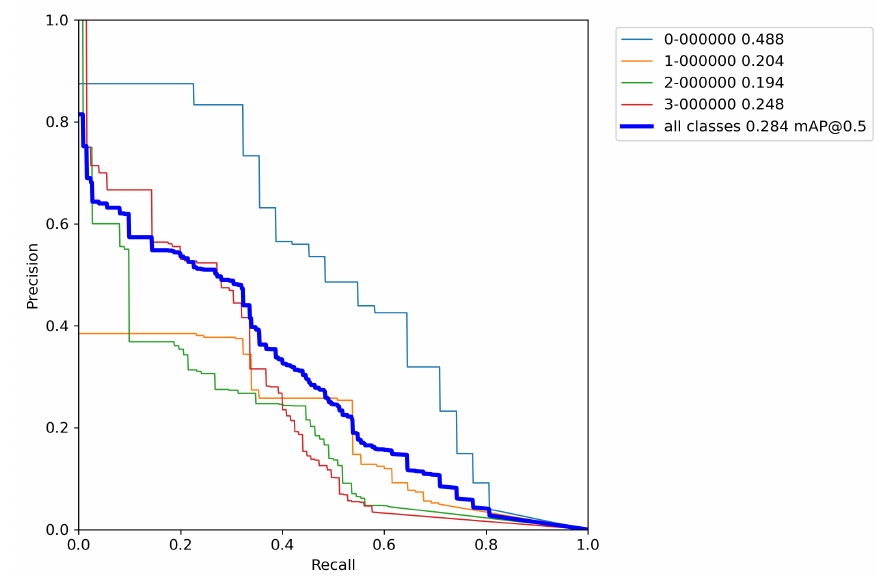
Figure A4. Base model P–R curve—Experiment 4.